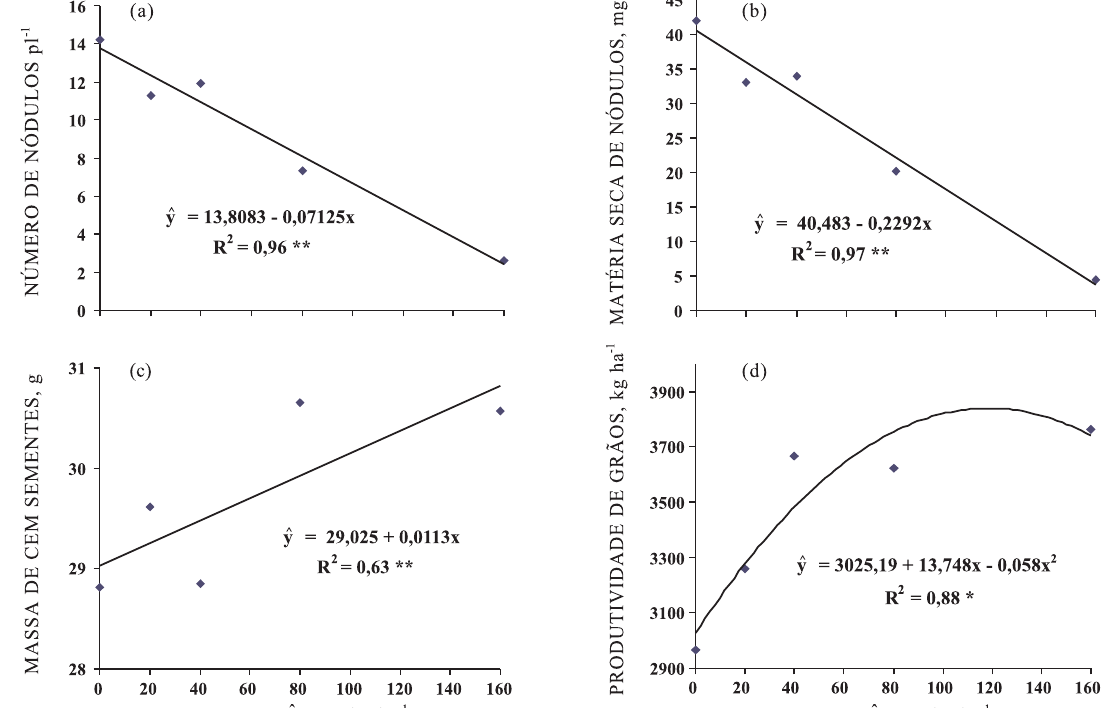
Figura 1. Número de nódulos (a), matéria seca de nódulos (b), massa de cem sementes (c) e produtividade de grãos de feijoeiro (d) em função da quantidade de nitrogênio fornecida, cv. Pérola. ** e *: significativo a 1 e 5 %,